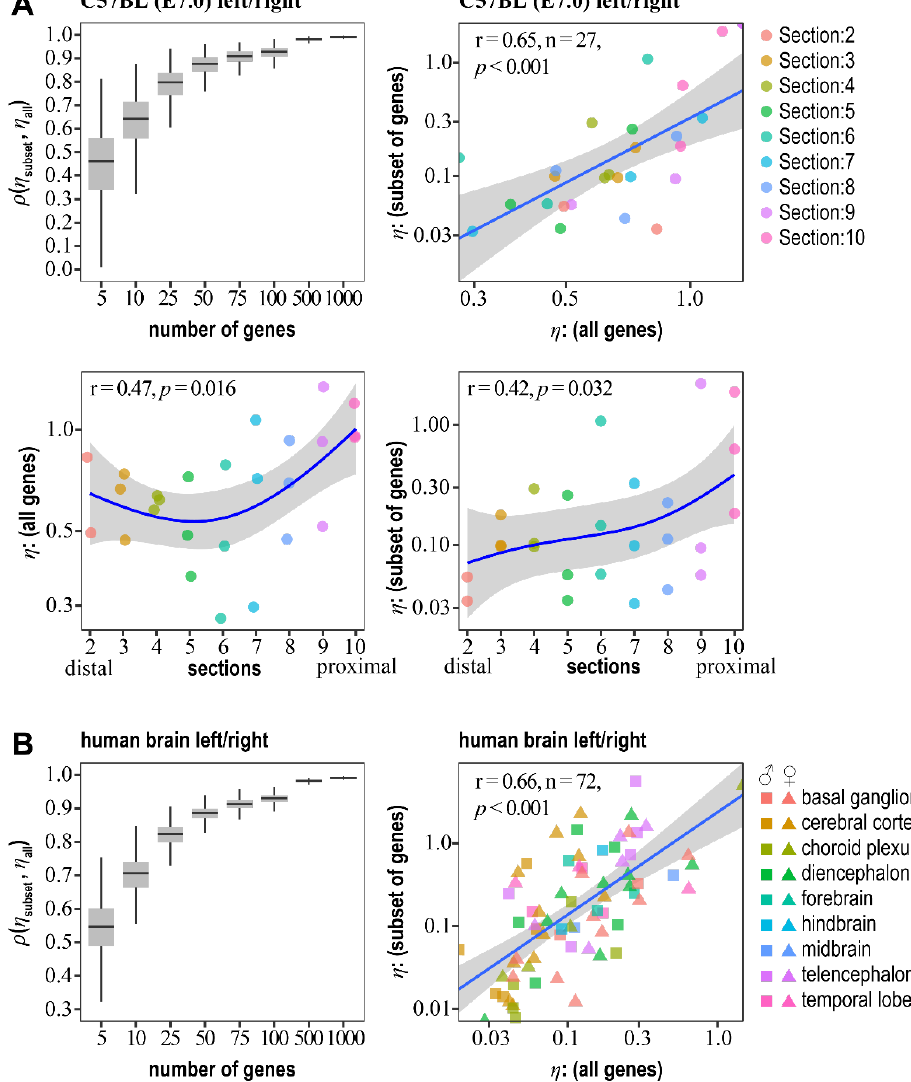
Figure 1. The distal – proximal gradient of pulled “intrinsic” gene noise in mouse embryo epiblast and correlations between pulled “intrinsic” gene noise estimated from the entire transcriptomes and random subsets of genes. ( A ) Boxplots of correlations of pulled “intrinsic” transcriptome noise ( 𝜂 𝑎𝑙𝑙 ) for mouse embryo epiblast left/right sections with estimates calculated for random subsets of genes ( 𝜂 𝑠𝑢𝑏𝑠𝑒𝑡 ) (top- left panel). Correlation between pulled “intrinsic” gene noise estimates from the en tire left/right transcriptomes and a selected subset of genes used for further RT-qPCR analysis (Supple- mentary Table S1) (top-right panel). Bottom panels: the distal – proximal gradient of pulled “intrin- sic” transcriptome noise in mouse embryo epiblast. The 𝜂 𝑎𝑙𝑙 (left panel) and 𝜂 𝑠𝑢𝑏𝑠𝑒𝑡 (right panel) were estimated for the entire transcriptome and selected for this study ’s subset of genes (Table S1), respectively. The blue curve indicates the fitted P-spline model and grey ribbon — 95% confidence interval. ( B ) Correlations between pulled “intrinsic” gene noise estimated from the entire transcrip- tomes and subsets of genes for human embryo s’ left/right brain structures.